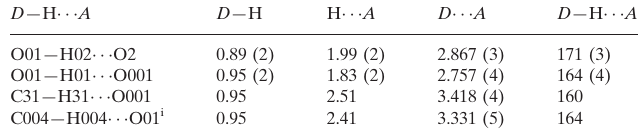
Hydrogen-bond geometry (A˚ , (cid:3)